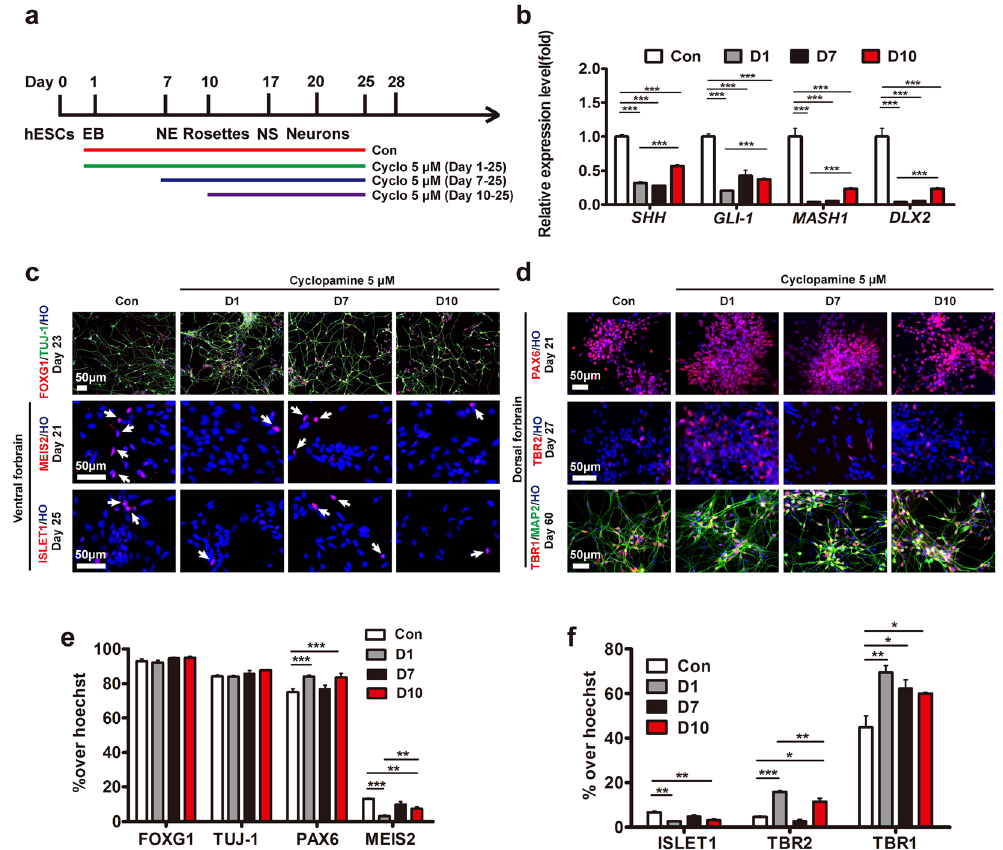
Figure 2. Early application of cyclopamine inhibited the generation of ventral neurons. ( a ) Timeline of differentiating hESCs to forebrain cortical neurons under the different time windows of cyclopamine. ( b ) Fold change of the specific mRNA level of the SHH , GLI-1 , and ventral forebrain ( MASH1 , DLX2 ) at d17. *** p < 0.001. The data are presented as the mean ± s.e.m, n = 3 in each condition. ( c ) Expression of the regionalization markers of the forebrain (FOXG1), and ventral forebrain (MEIS2, ISLET1) (arrows) among the neuron (TUJ-1) from d21 to d25. Scale bar, 50 μ m. ( d ) Expression of the cortical neuron markers including PAX6, TBR2, TBR1 from d21 to d60. Scale bar, 50 μ m. ( e ) and ( f ) Proportion of the total cells expressing neuronal regionalization markers from d21. * p < 0.05; ** p < 0.01; *** p < 0.001. More than 1,500 cells from random fields were manually counted in each condition. The data are presented as the mean ± s.e.m, n ≥ 3 in each